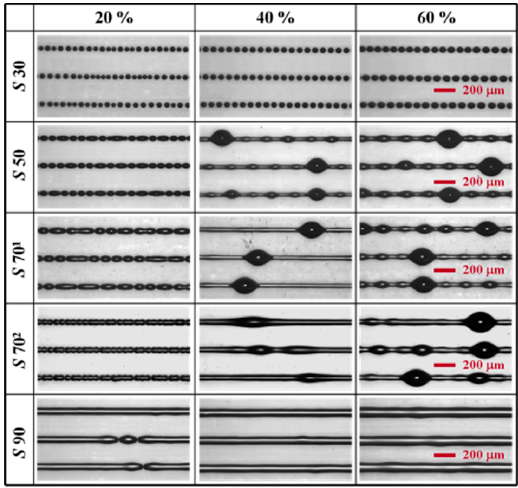
Figure 5. Microscopic images of inkjet-printed lines with 200 Hz printing frequency for various types of substrates and droplet overlaps at room temperature when using continuous printing procedure.